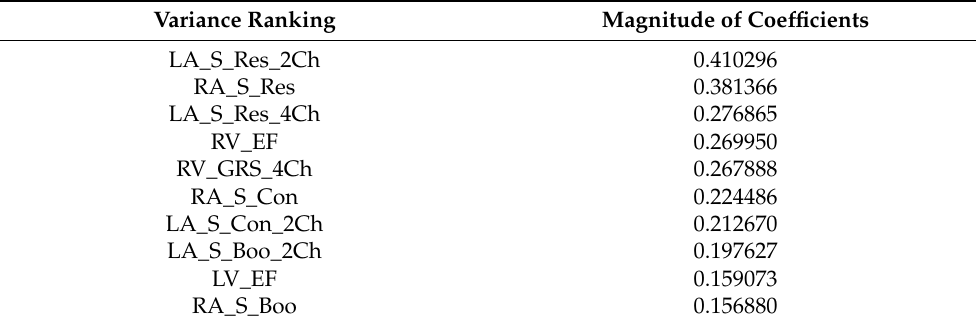
Figure 4. The confusion matrices for 41-feature k-nearest neighbor (KNN), decision tree (DT), SVM radial basis function (RBF) kernel and for 10-feature principal component analysis (PCA + SVM RBF kernel) are presented with corresponding performance statistics. Precision = positive predictive value, recall score = sensitivity, F1-score = test accuracy, Support = number of subjects tested, SVM = support vector machine, RBF = radial basis function, PCA = principal component analysis. Table 2. Top ten highest rates for the first principal